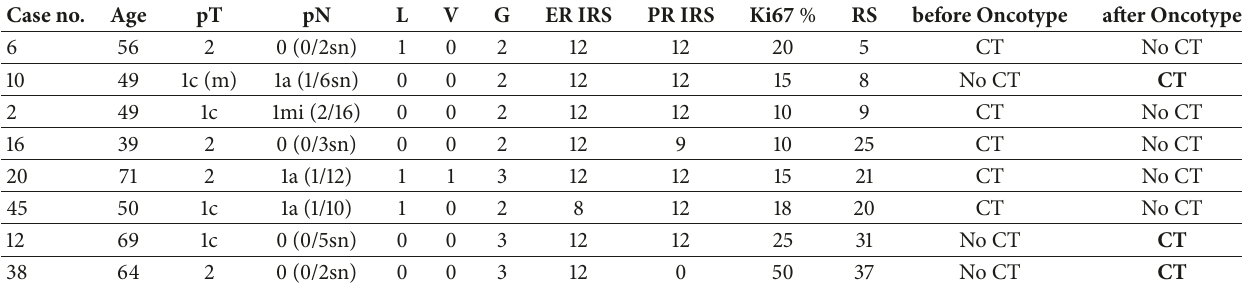
Table 4: Details for cases with change of recommendation. ER/PR IRS: immunoreactive score for hormone receptors; RS: recurrence score; CT: adjuvant